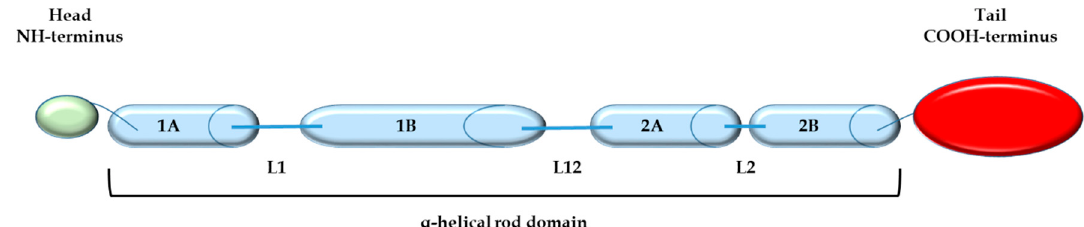
Figure 1. Nestin’s structure consists of a central α -helical rod domain (blue) flanked by globular NH (green) and COOH (red) domains. The α -helical rod domain consists of segments 1A and 1B separated by linker L1 and segments 2A and 2B with linker L2 between them, separated from 1B by linker L12.